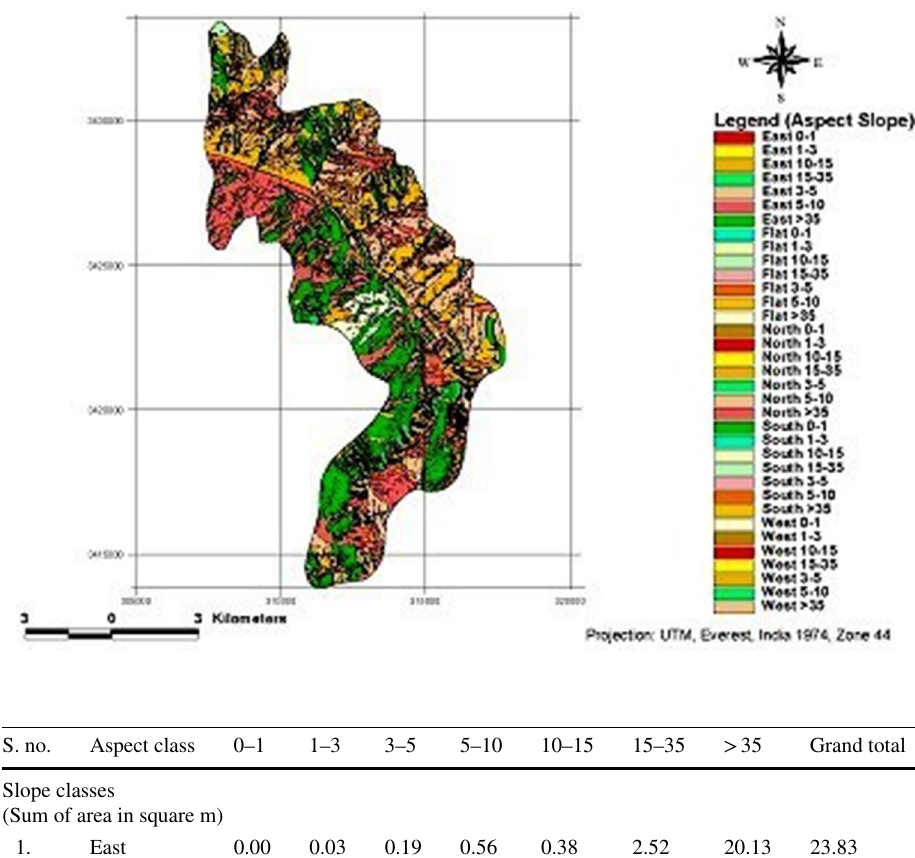
Fig. 11 Vulnerability map of Gangotri glacier based on slope classes with aspects